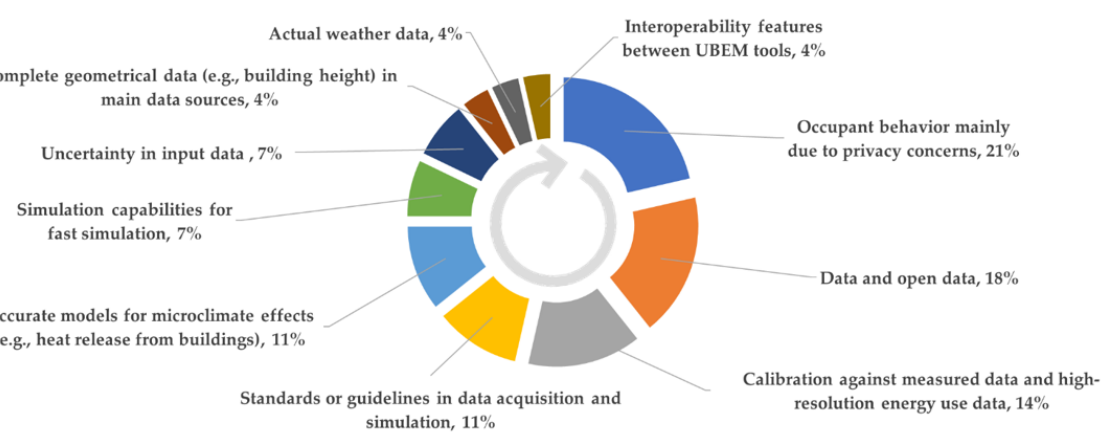
Figure 21. Areas in physics-based urban building energy modeling with shortcomings identified by researchers.